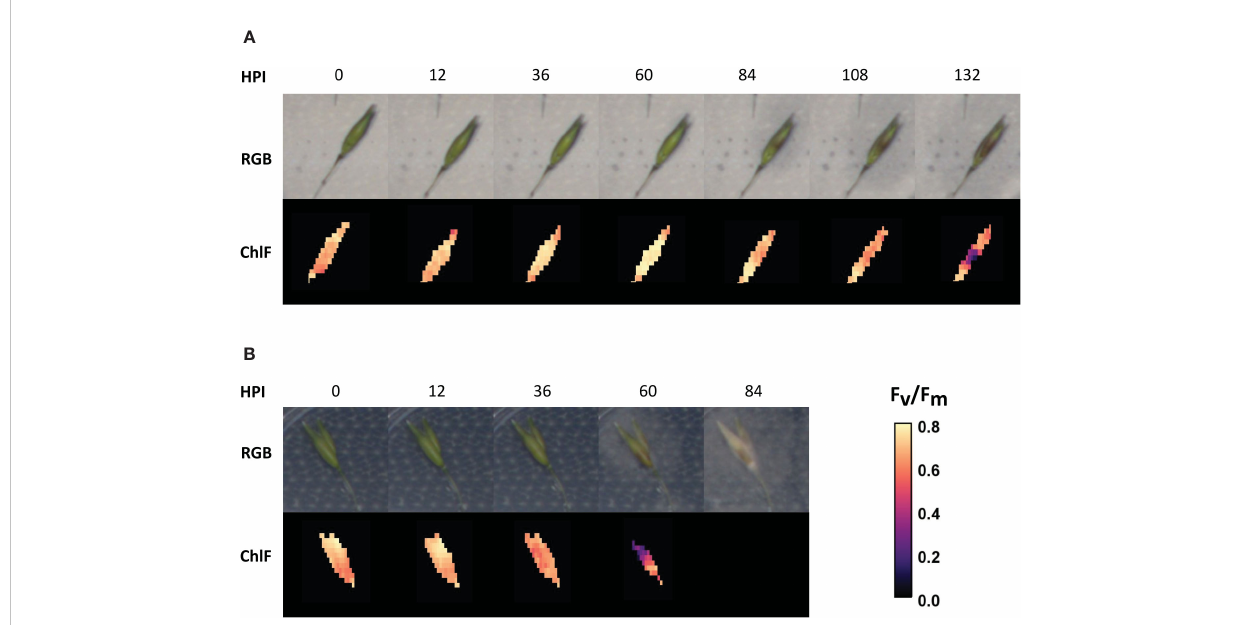
FIGURE 2 Time series of oat genotype BOR31 spikelets after inoculation with the two Fusarium species. (A) The progression of F. langsethiae hyphae growth over an example spikelet (RGB) and the decline of ChlFl in the same sample. (B) The progression of F. culmorum hyphae growth on one BOR31 spikelet by RGB and the decline of chlorophyll fl uorescence (ChlFl) on the same sample. HPI, hours post